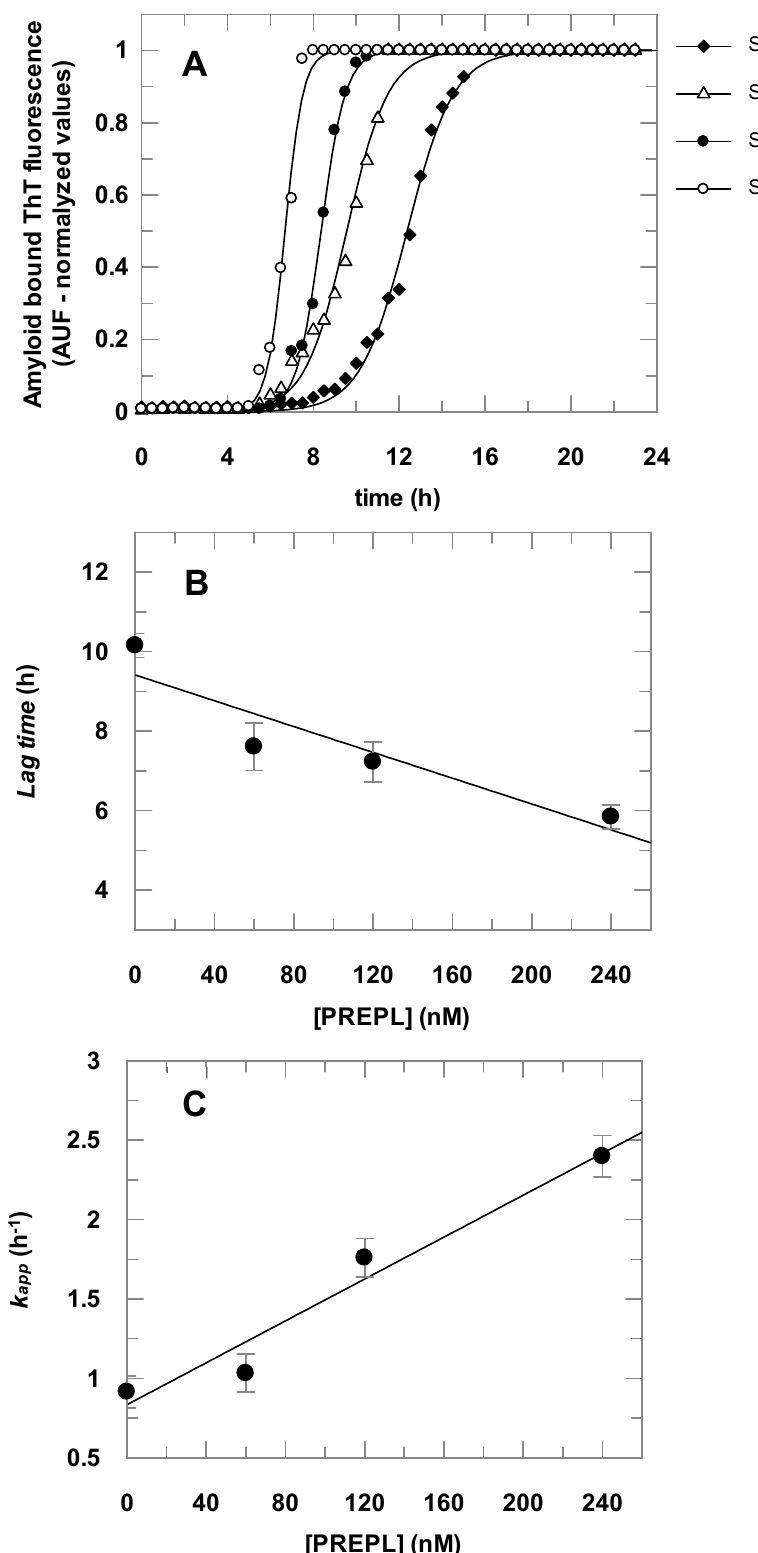
Figure 4. E ff ect of PREPL on the α -Syn aggregation. Panel A : The α -Syn amyloid fibril formation was monitored by thioflavin T (ThT) fluorescence for 24 h. The assays were carried out in the absence